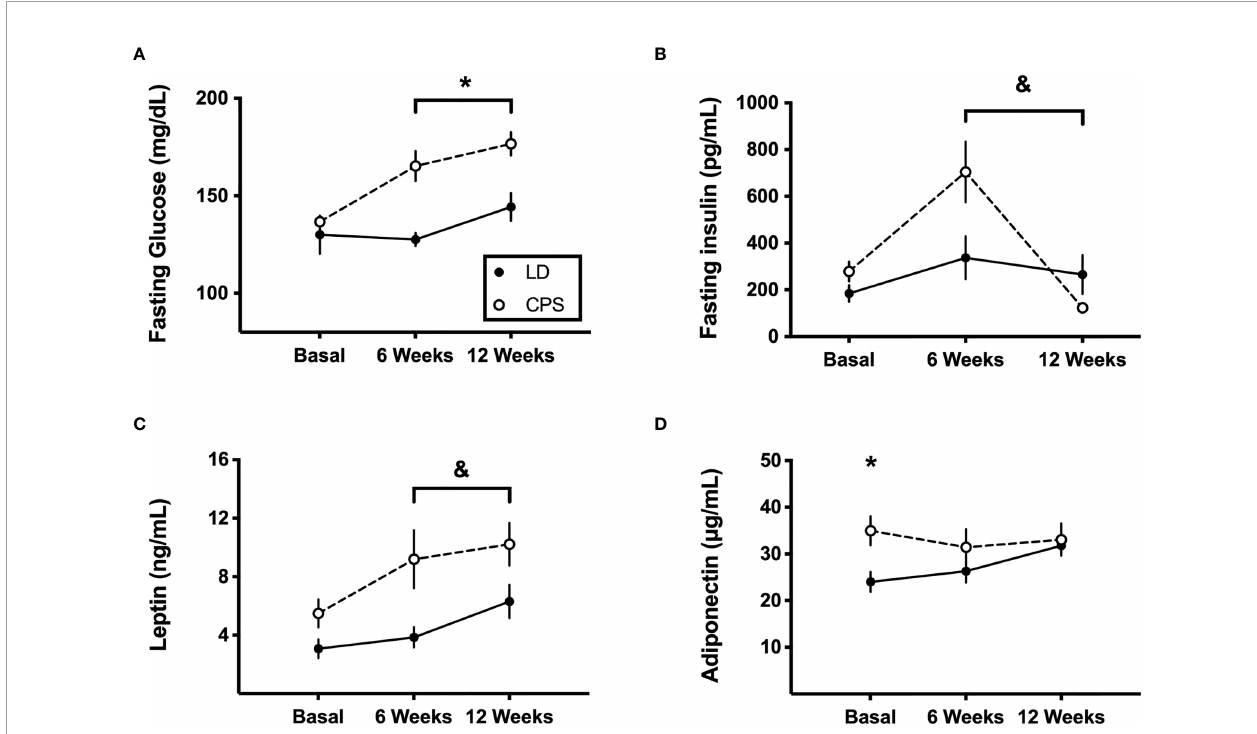
FIGURE 5 | Effects of gestational chronic phase shift of photoperiod on serum levels of fasting glucose (A) , fasting insulin (B) , leptin (C) , and adiponectin (D) at 6 and 12 weeks of 45% high-fat diet intake. Data are mean±SEM. Solid line: LD, adult rats that had been gestated under control 12:12 (LD) photoperiod. Dashed line: CPS, adult rats that had been gestated under chronic phase shift (CPS) photoperiod. n = 8 per group. *Different from LD ( p < 0.05; two-way ANOVA and Bonferroni test). & Different from basal ( p < 0.01; two-way ANOVA and Bonferroni